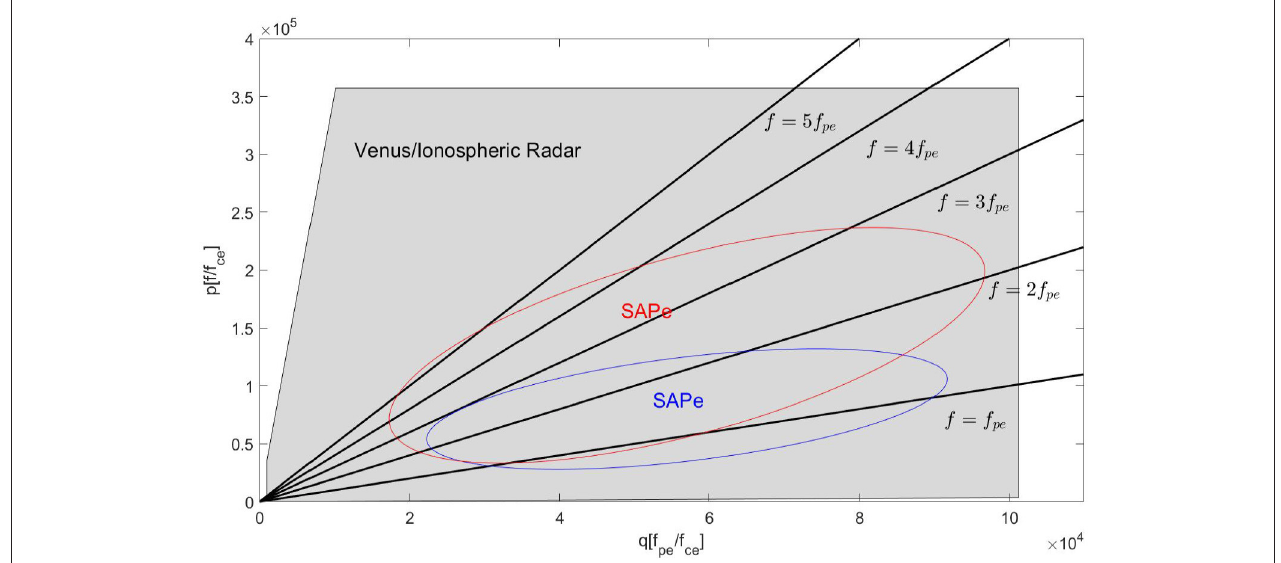
FIGURE 8 | Expectations of the SAP in the ionosphere of Venus. The gray area shows the range of the p − q parameters for the expected Venus environment and SRS sounding characteristics of the radar onboard ISRO Venus Orbiter. The areas encircled by red and blue indicate the possibility of the SAP